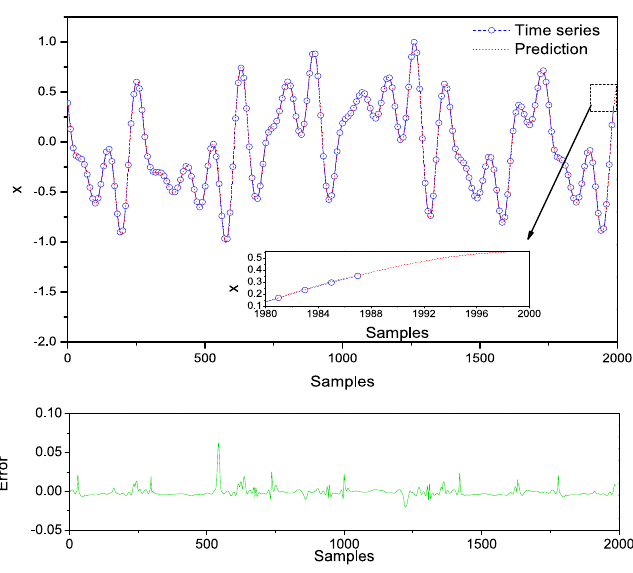
Figure 12. Twelve steps ahead prediction result of the five-layer MLP for the chaotic time series with MLE =